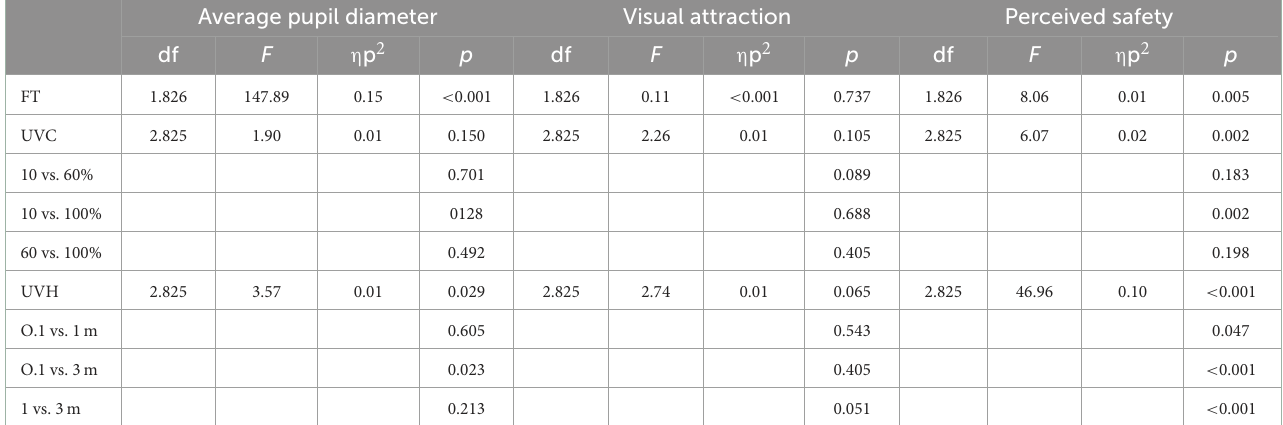
TABLE 3 ANOVA analysis for average pupil diameter, the scores of visual attraction, and perceived safety. Average pupil diameter Visual